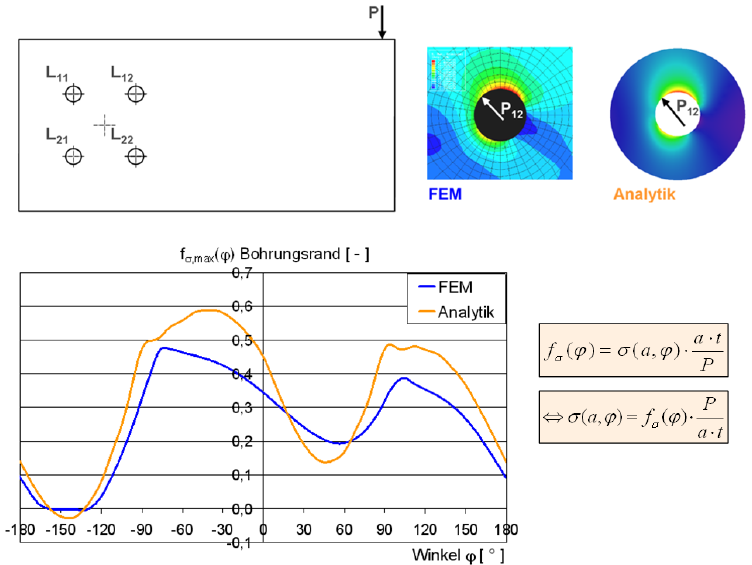
Figure 10: Comparison of results of analytical to Finite Element calculations for a joint in bending and shear, evaluation of hole L 12